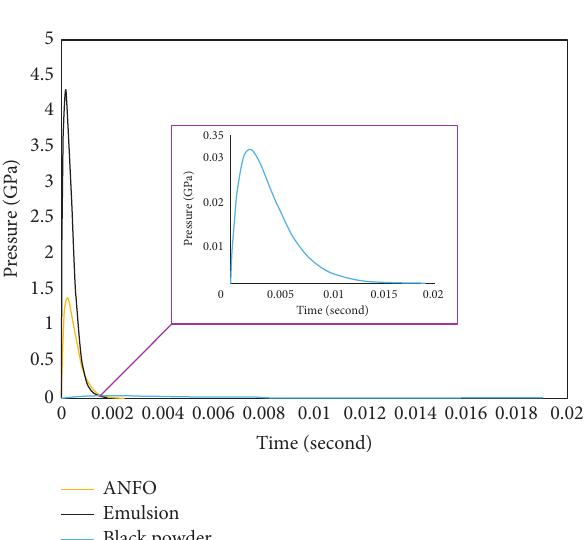
Figure 10: The pressure-time diagrams for different explosives used in this study using equation